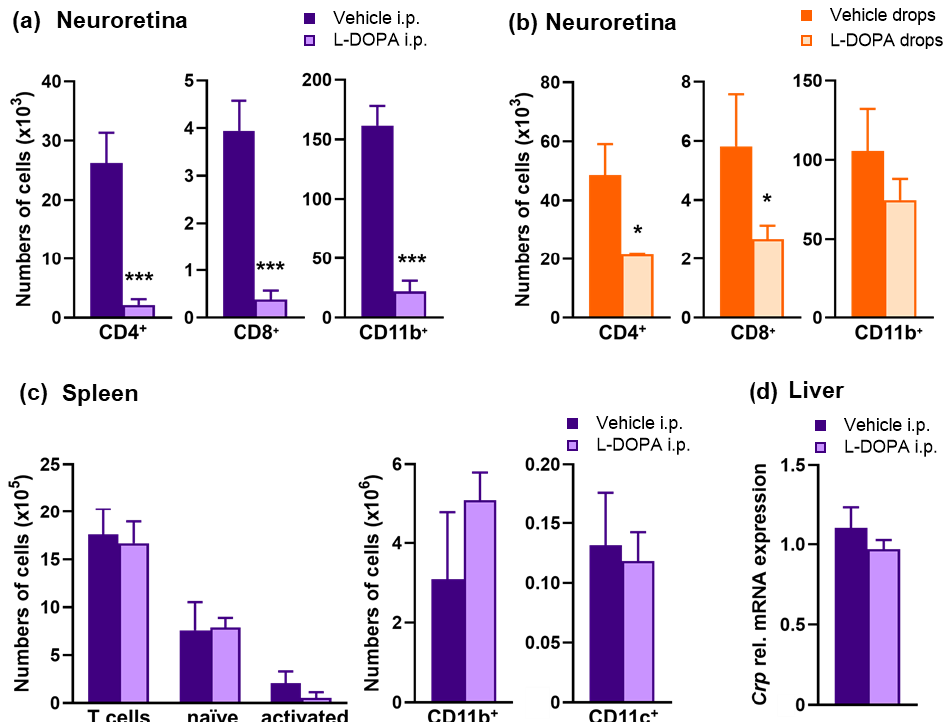
Figure 8. L-DOPA treatment in EAU Gnat1 rd17 mice decreases retinal infiltration of immune cells. Absolute numbers of neuroretina-infiltrating CD4 + , CD8 + , and CD11b + cells in EAU Gnat1 rd17 mice treated with vehicle or L-DOPA given ( a ) i.p. or as ( b ) eye drops (day 14 after immunization) were measured by flow cytometry. The data shown are the mean ± SEM of 6–8 neuroretinas from 6–8 mice per group and are representative of two experiments. * p < 0.05 and *** p < 0.001 by unpaired t -test for comparisons between groups receiving i.p. injections of vehicle and L-DOPA, respectively, and paired t -test for comparisons between groups of vehicle-treated contralateral eyes and L-DOPA-treated ipsilateral eyes in the same animals. ( c ) Absolute numbers of CD3 + T cells, naïve CD4 + T cells (CD4 + CD44 low ), activated CD4 + T cells (CD4 + CD44 high ), CD11b + (CD11b high CD11c low , macrophages, and neutrophils), and CD11c + (CD11c high MHC-II high , dendritic cells) in spleens of EAU Gnat1 rd17 mice treated with i.p. injections of vehicle or L-DOPA. Flow cytometry was used